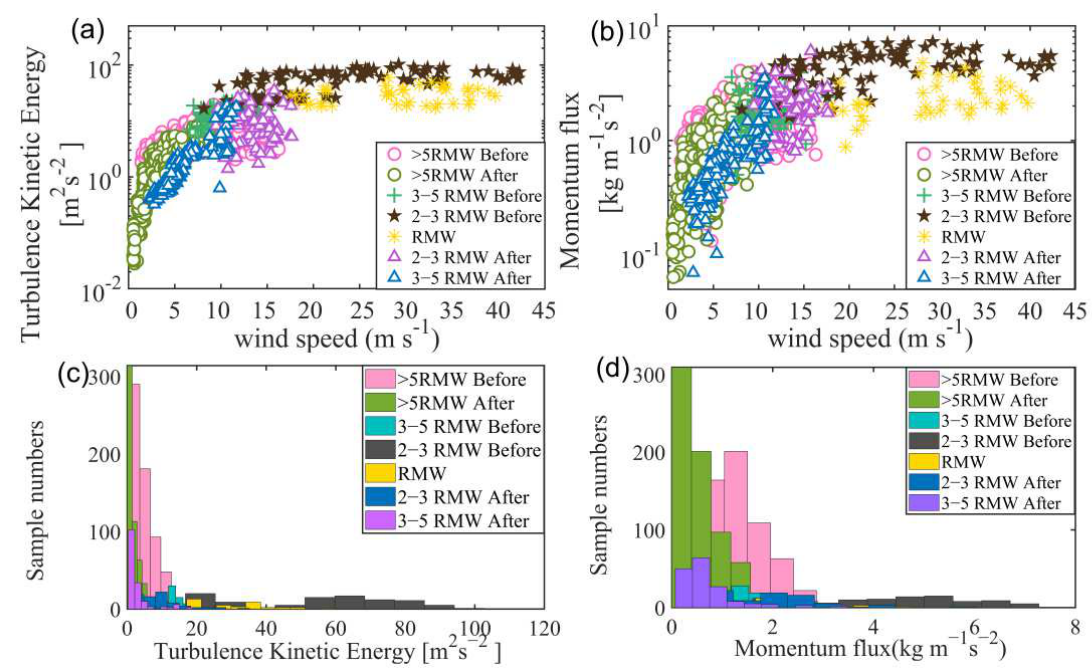
Figure 10. Plots of the ( a ) momentum fluxes and ( b ) turbulent kinetic energy versus wind speed as a function of the TC radius normalized by the maximum wind speed radius (RMW). The data were classified into seven categories according to the TC radius normalized by RMW. Histograms of the ( c ) turbulent kinetic energy and ( d ) momentum fluxes. Each color represents the seven categories defined by the TC radius normalized to